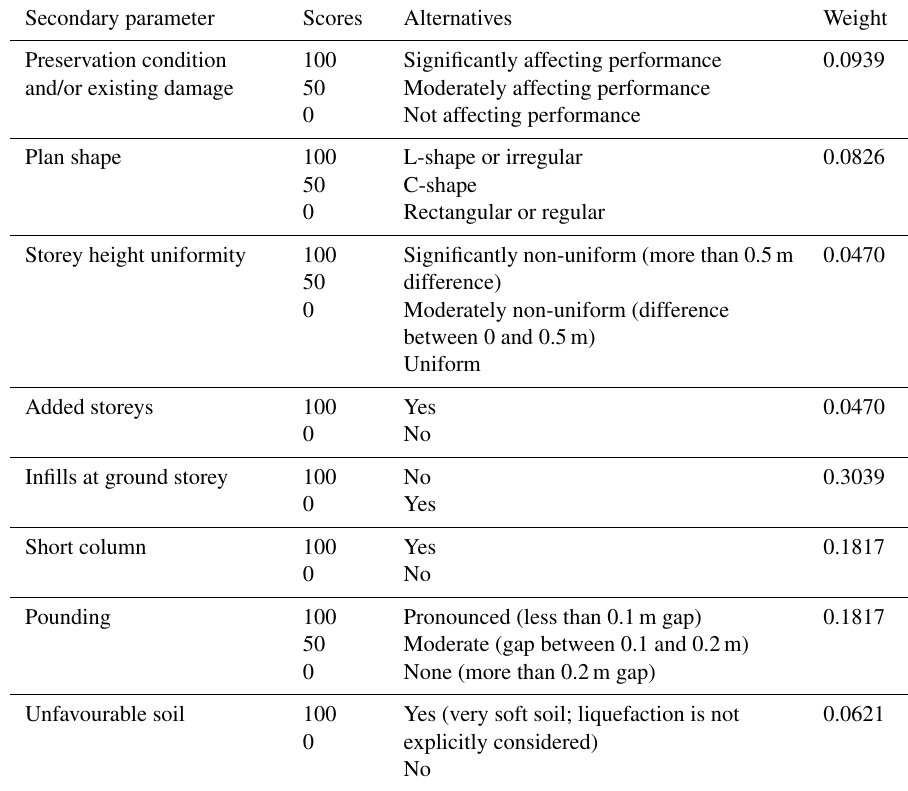
Table 3. Secondary parameters: definition, available alternatives, related scores and weights.